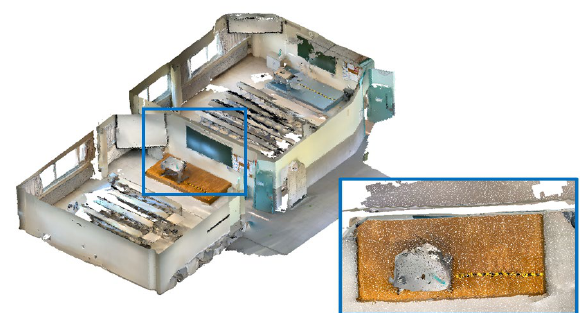
Figure 2: The indoor scene composed of two consecutive rooms scanned with iPad Pro, and a zoom from a top